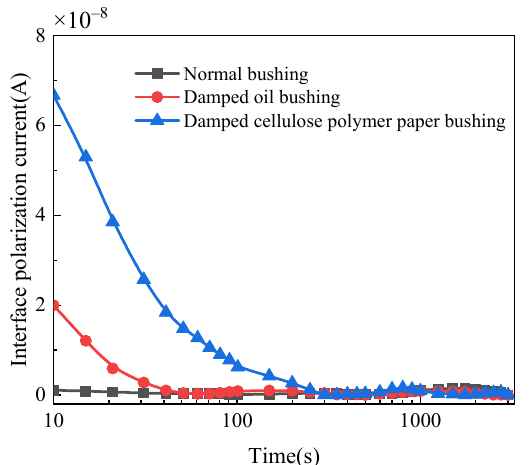
Figure 10. Interface polarization current of bushings with different moisture